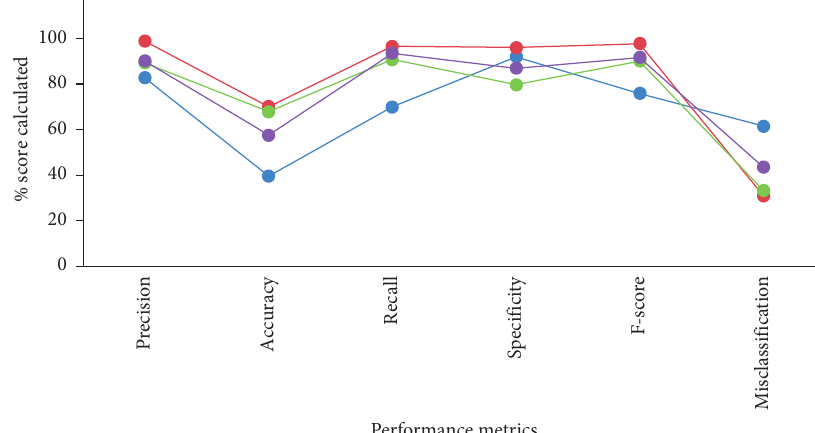
Figure 8: Decomposition tree based-performance results.